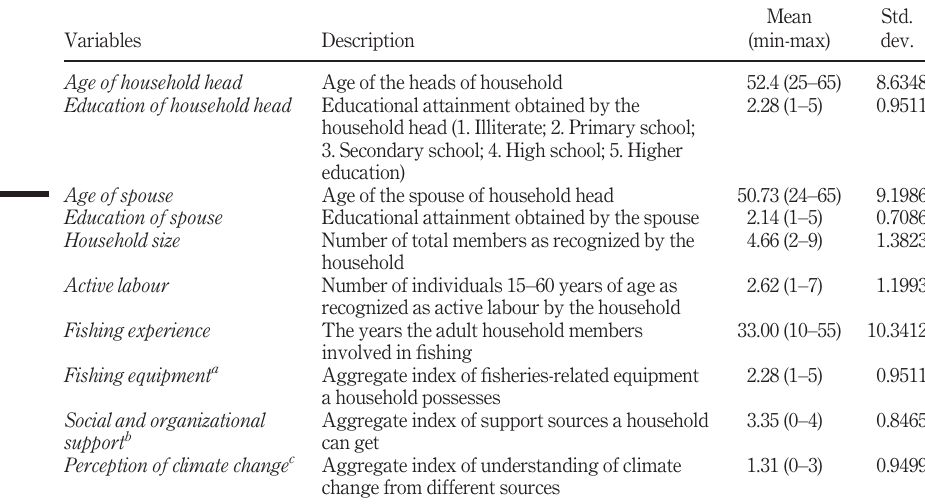
Table 1. Socio-demographic characteristics of the sampled fi shing households in the research sites